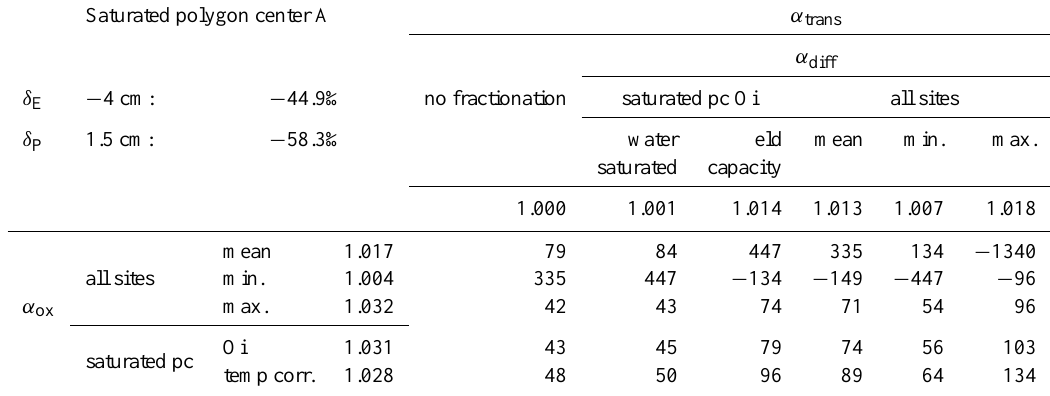
Table 4. Calculated CH 4 oxidation efficiency f ox in percent for the saturated polygon center A (“saturated pc”) between 1.5cm below ( δ P ) and 4cm above ( δ E ) soil surface according to Eq. (3) applying the fractionation factors α ox and α diff of the respective horizon (horizon Oi). Calculations were further conducted with the mean, minimum and maximum of both fractionation factors of all investigated sites, with α ox corrected for temperature according to Chanton et al. (2008b) and with α trans =1 (no fractionation due to